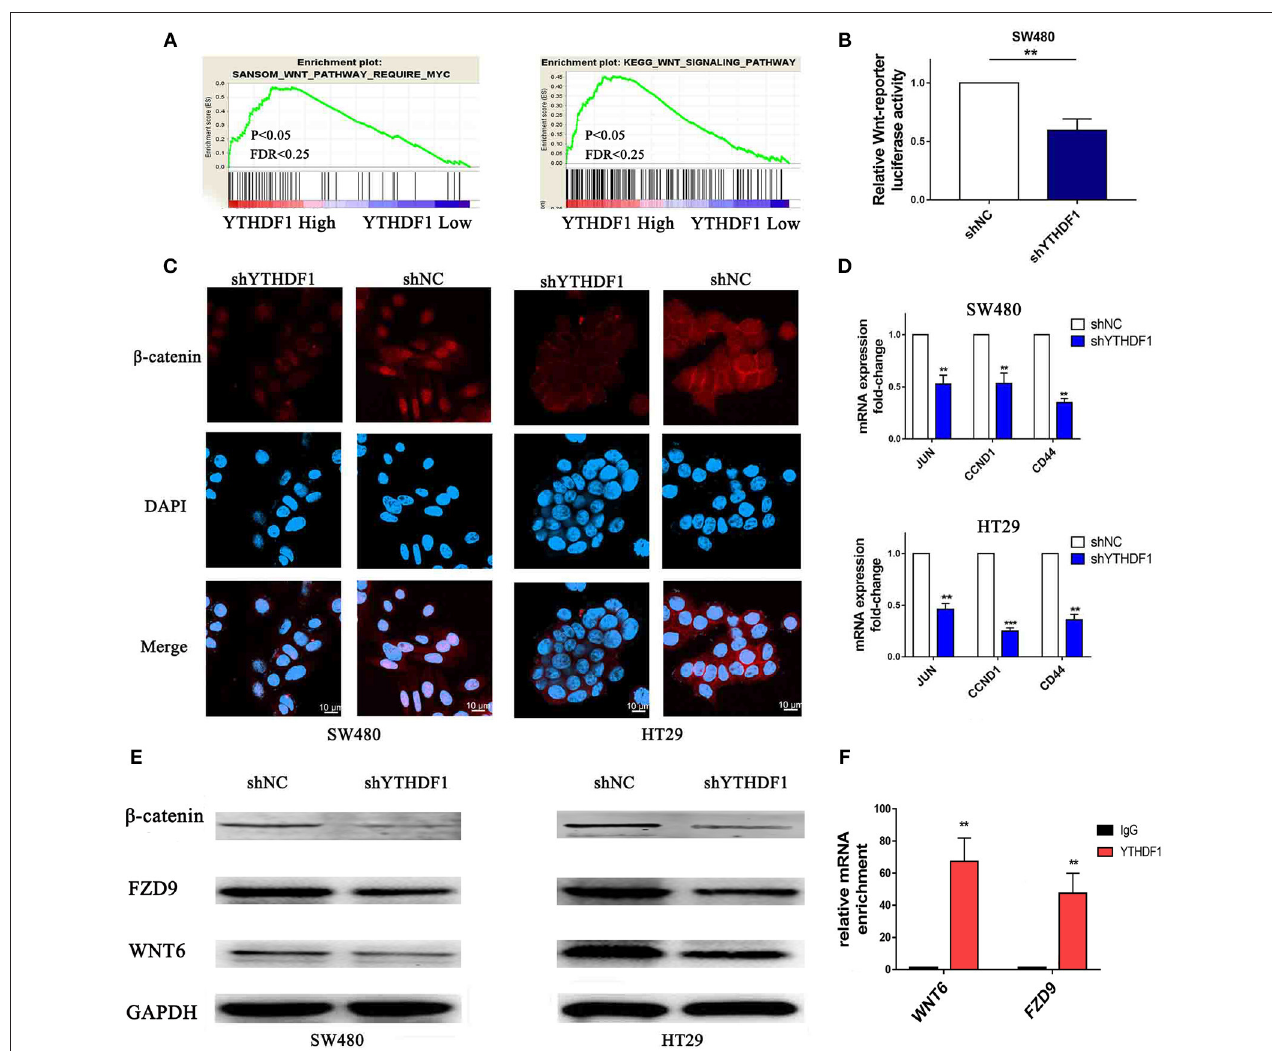
FIGURE 7 | Silencing of YTHDF1 Inhibits the Wnt/ β -Catenin Pathway in CRC Cells. (A) GSEA showing the positive correlations between YTHDF1 mRNA levels and Wnt signaling based on publicly available CRC profiles. (B) Luciferase-reporter assays of TOP/FOP transcriptional activity in the CRC cells (C) Immunofluorescence staining detected the protein expression and localization of β -catenin (scale bar, 10 µ m;). (D) Real-time PCR of the mRNA expression of Wnt/ β -catenin downstream genes (JUN, CCND1, CD44); (E) Western blotting analysis WNT6, FZD9 and non-phospho (active)- β -catenin protein expression in CRC cells. (F) . Real-time PCR of WNT6 and FZD9 enrichment of YTHDF1 compared with IgG. (** P < 0.01; *** P < 0.001).